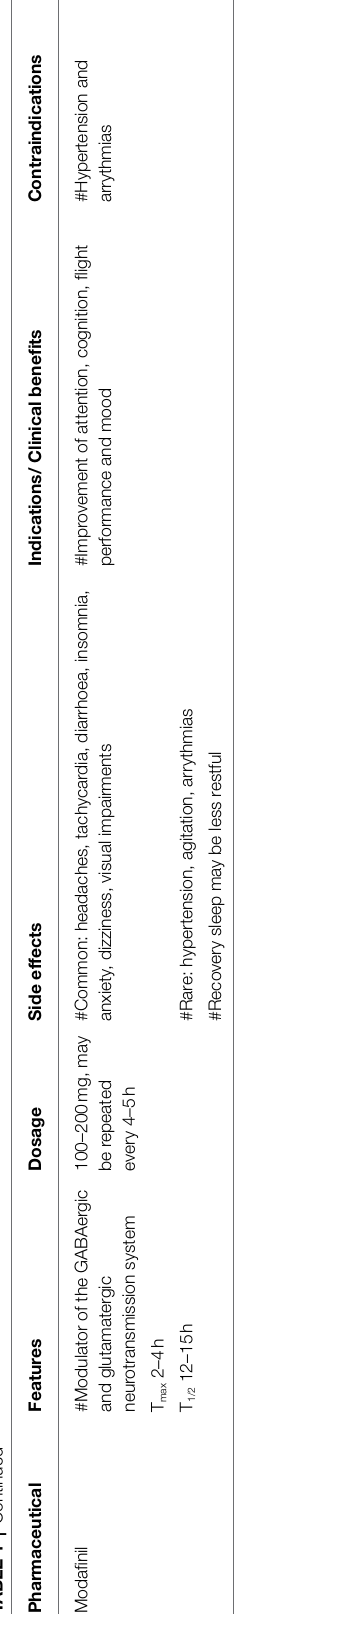
TABLE 2 | Comparison between controlled rest and bunk rest.